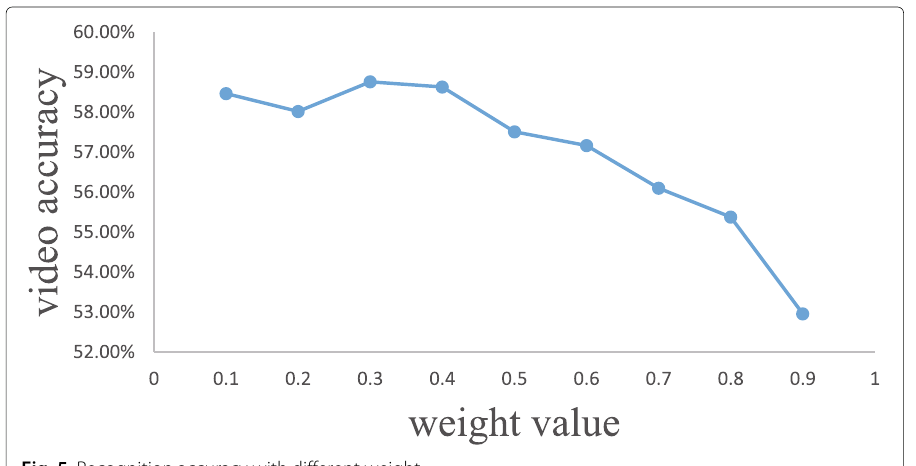
Fig. 5 Recognition accuracy with different weight